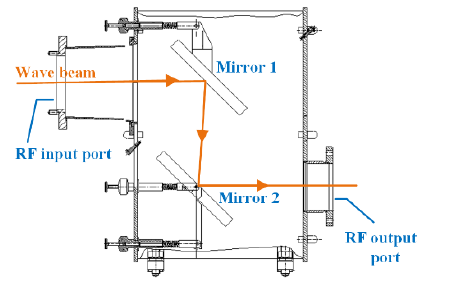
Fig. 3. Magnet resistance change ( a ) and magnet temperature change ( b ) during the cooling down process.